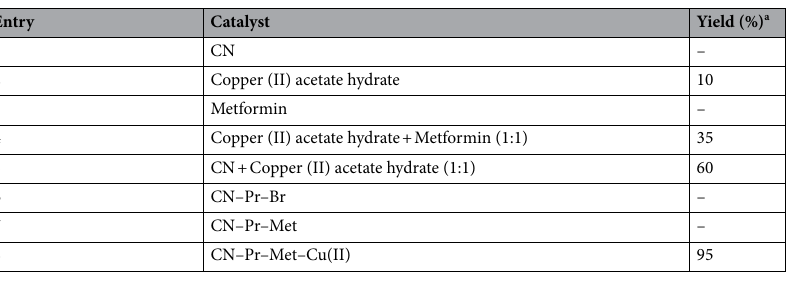
Table 2. A comparison of the catalytic efficiency of CN–Pr–Met–Cu(II) and its components in tandem oxidative amidation of benzylic alcohols. Reaction condition: benzylamine hydrochloride (1.0 mmol),